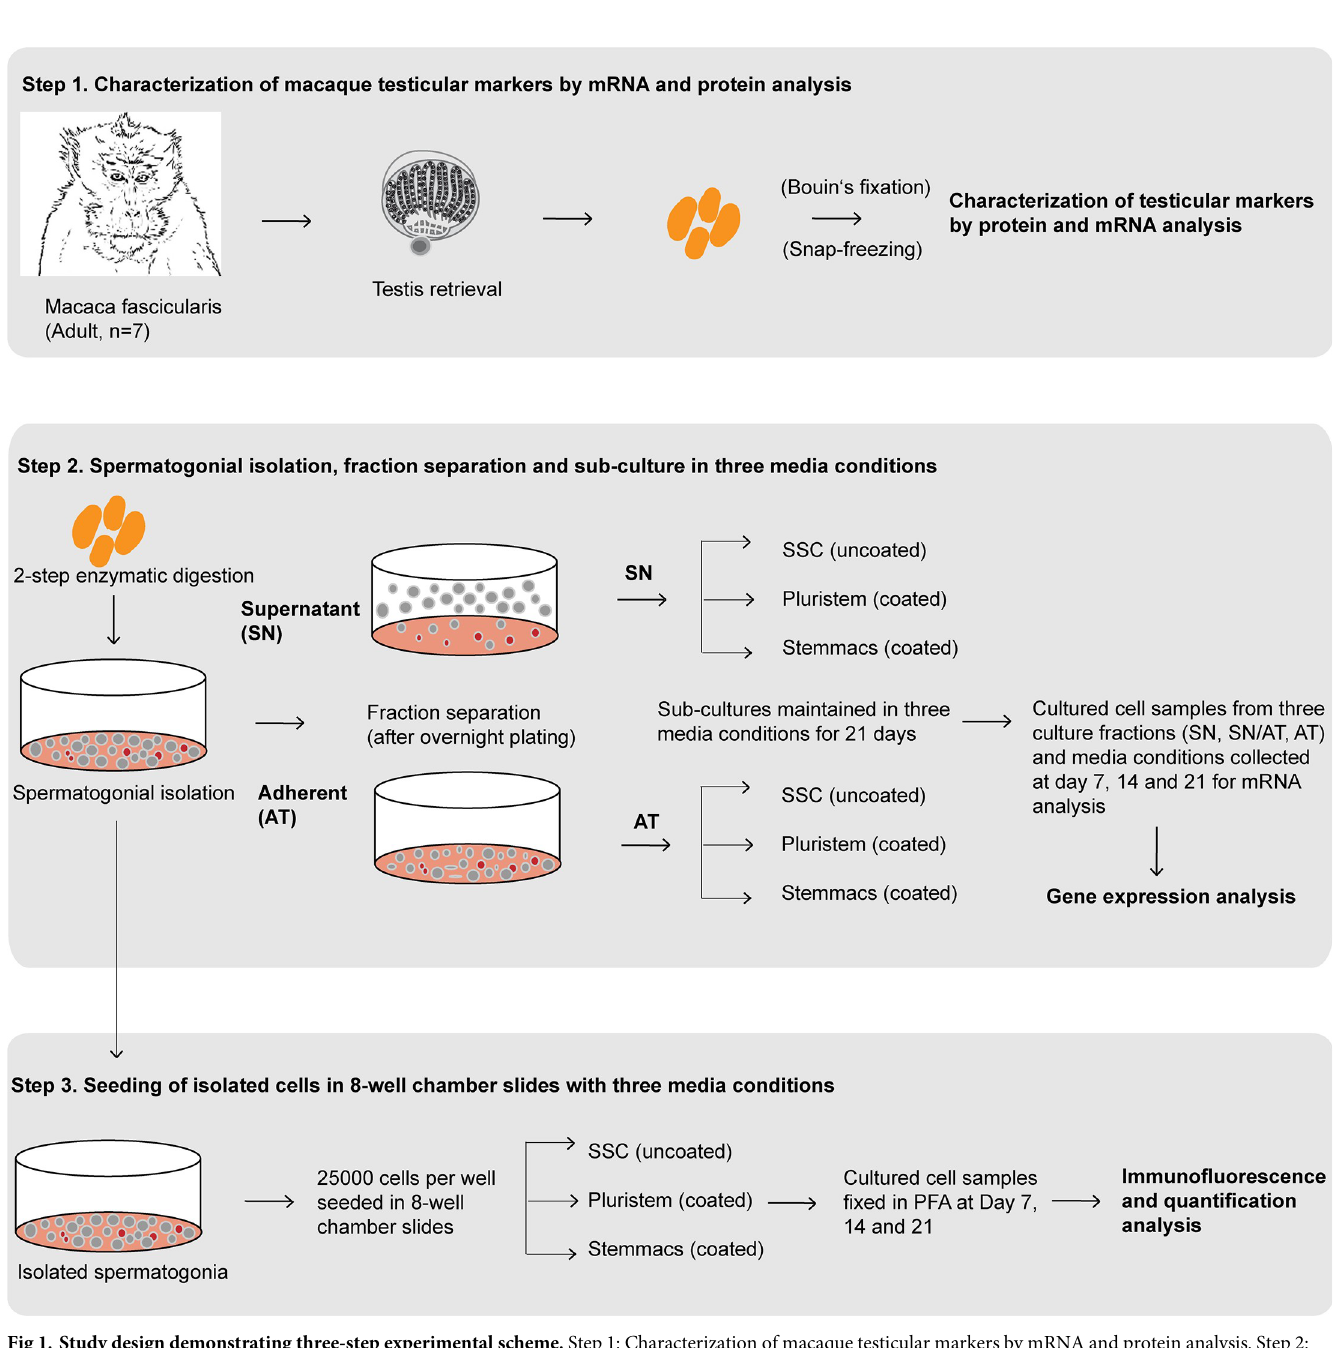
Fig 1. Study design demonstrating three-step experimental scheme. Step 1: Characterization of macaque testicular markers by mRNA and protein analysis. Step 2: Spermatogonial isolation, separation of supernatant (SN) and adherent (AT) fractions and sub-culture in three media conditions (Spermatogonial stem cell (SSC), Stemmacs (SM) and Pluristem (PS) media). Gene expression analysis of cultured cells collected at day 7, 14 and 21. Step 3: Seeding of isolated spermatogonia (25,000 cells per well) in 8-well chamber slides with three media conditions. Fixation of cells cultured in three media conditions in 4% Para-formaldehyde (PFA) at day 7, 14 and 21. Immunofluorescence analysis for expression of germ cell markers MAGEA4 and VASA in vitro and quantification of cells and clusters expressing MAGEA4 in vitro during